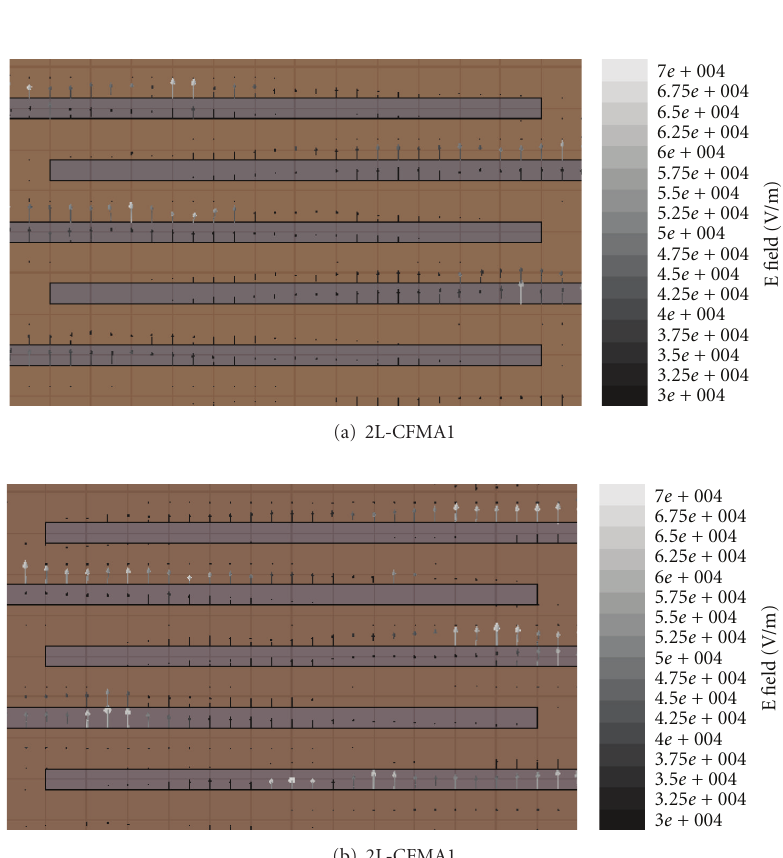
Figure 7: Electric field on the meander